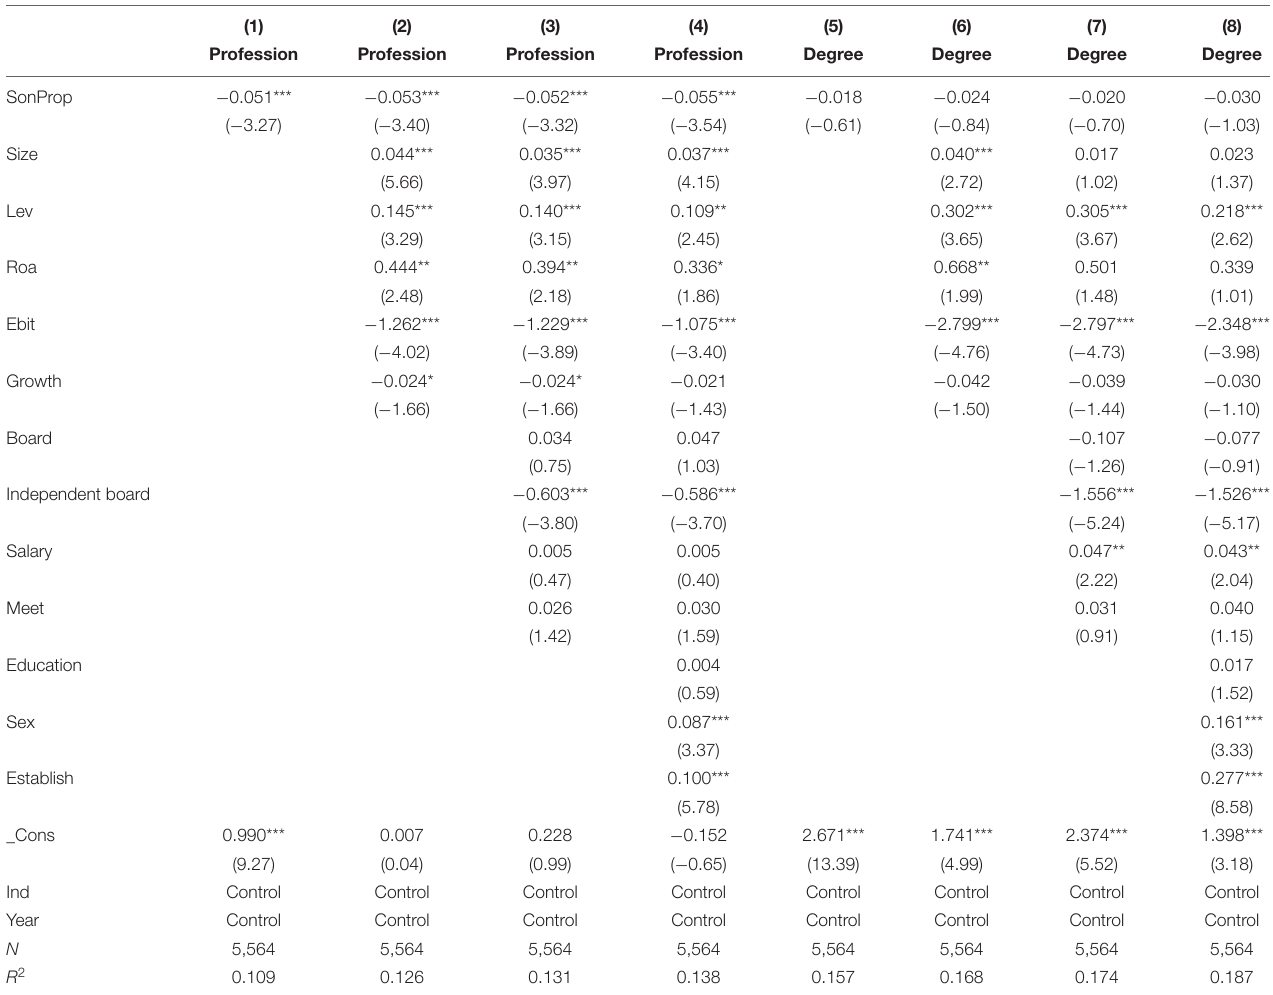
TABLE 5 | Multiple regression analysis: the proportion of sons of actual controllers and professional